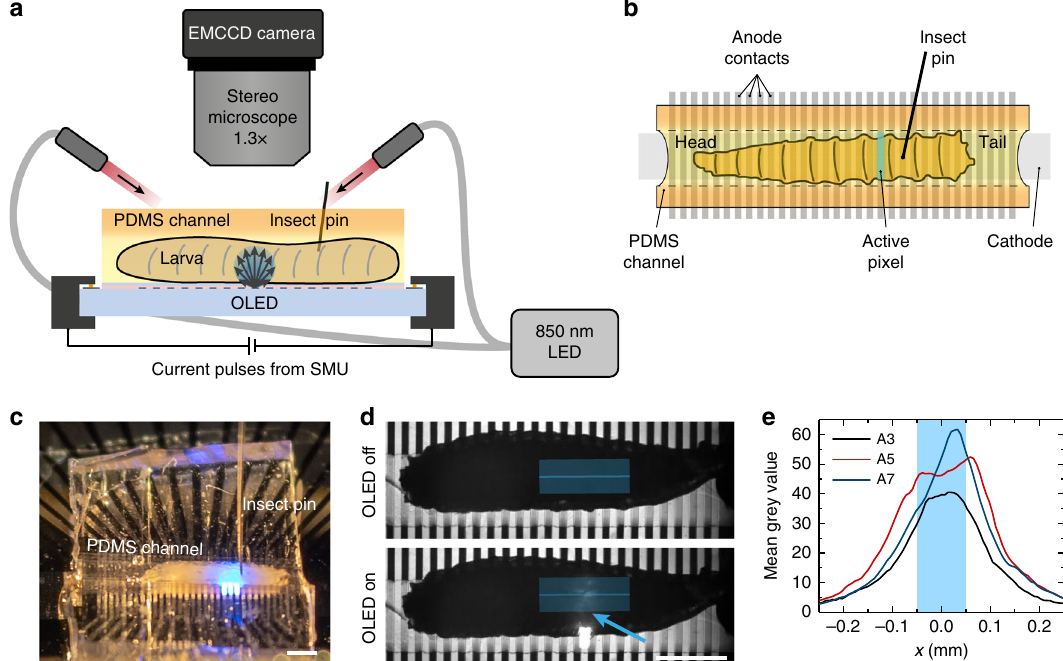
Fig. 2 Structured light source for segment-speci fi c illumination of Drosophila larvae. a Sketch of the experimental setup (side view) and b of the larva mounted on top of the OLED and inside the PDMS channel (top view). c Photograph of a larva mounted in a PDMS channel on top of a microstructured OLED. d Exemplary images used to estimate the spatial resolution of photostimulation from the pro fi les of scattered light at the top side of the larva; blue line: extracted emission pro fi le (width: 37 px); the arrow points to the active pixel. e Pro fi les taken during illumination of different abdominal segments. The blue shaded area marks the 100 µ m wide OLED pixel. Scale bars in c and d : 1